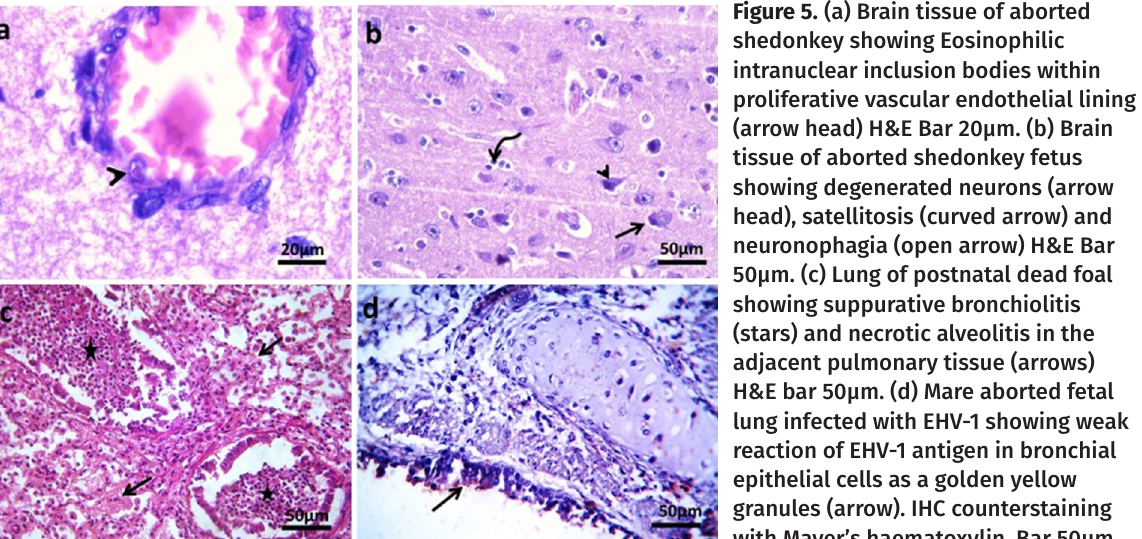
Figure 5. (a) Brain tissue of aborted shedonkey showing Eosinophilic intranuclear inclusion bodies within proliferative vascular endothelial lining (arrow head) H&E Bar 20µm. (b) Brain tissue of aborted shedonkey fetus showing degenerated neurons (arrow head), satellitosis (curved arrow) and neuronophagia (open arrow) H&E Bar 50µm. (c) Lung of postnatal dead foal showing suppurative bronchiolitis (stars) and necrotic alveolitis in the adjacent pulmonary tissue (arrows) H&E bar 50µm. (d) Mare aborted fetal lung infected with EHV-1 showing weak reaction of EHV-1 antigen in bronchial epithelial cells as a golden yellow granules (arrow). IHC counterstaining with Mayer’s haematoxylin. Bar 50µm.